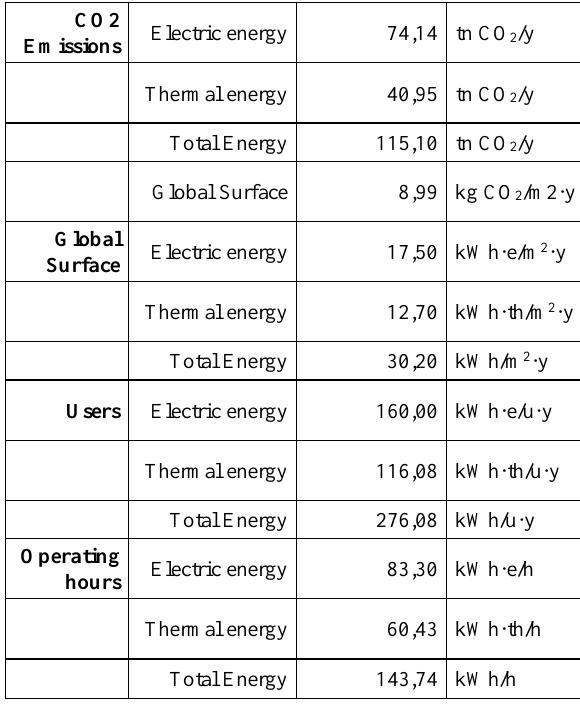
Table 1. Main KPIs for CIPFP Blasco Ibáñez .